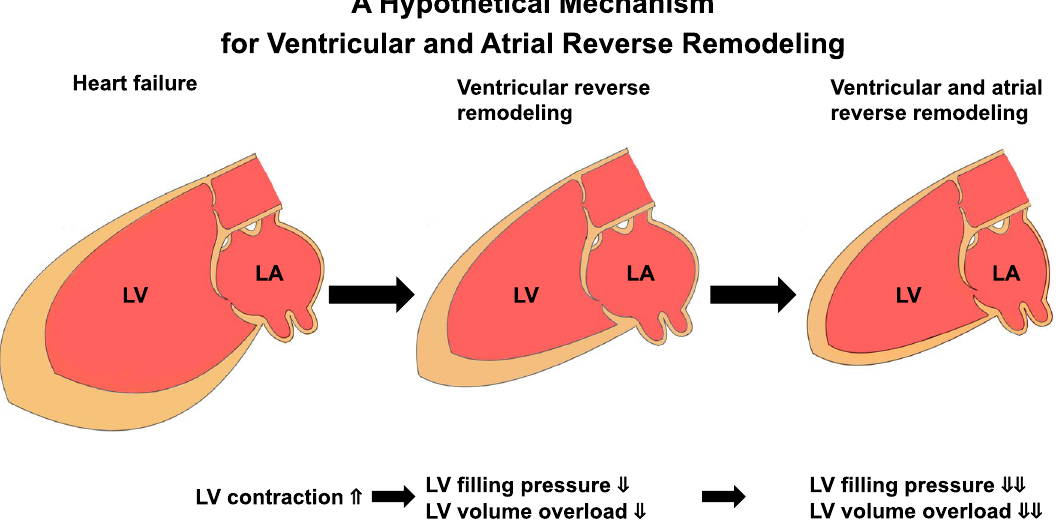
Figure 4. A hypothetical mechanism for ventricular and atrial reverse remodeling. LV, left ventricle; LA, left